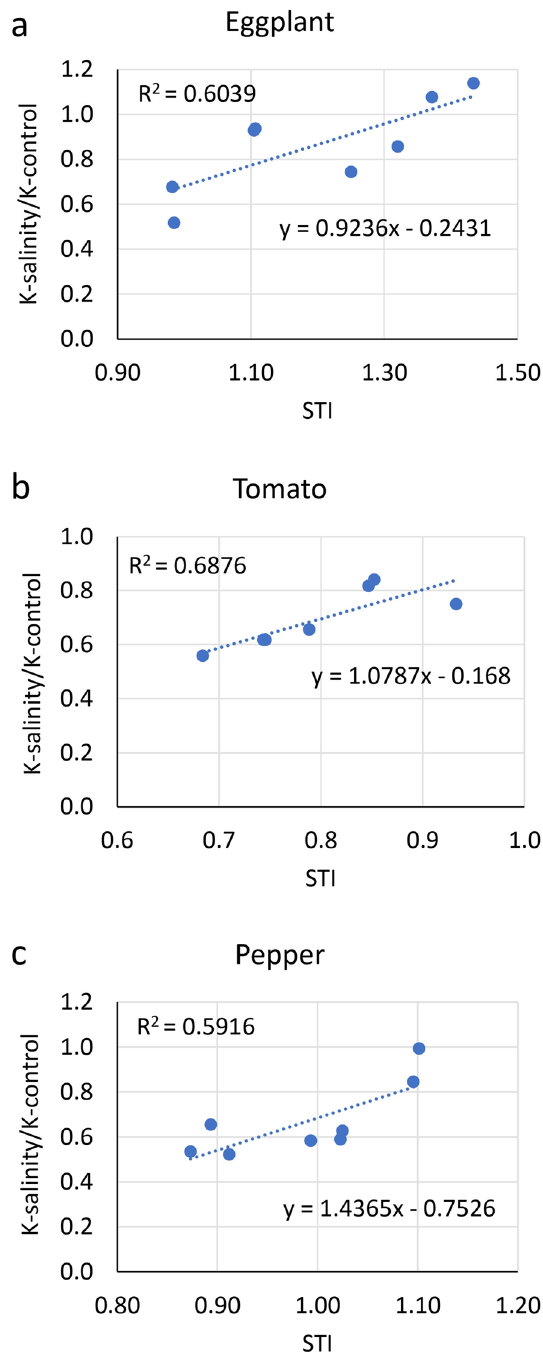
Figure 5. Relationship of the ratio of leaf K under salinity and control (K-salinity/K-control) with salt tolerance index (STI) in eggplant, tomato, and pepper. ( a ) Eggplant. ( b ) Tomato. ( c ) Pepper. Dots represent the mean values of different